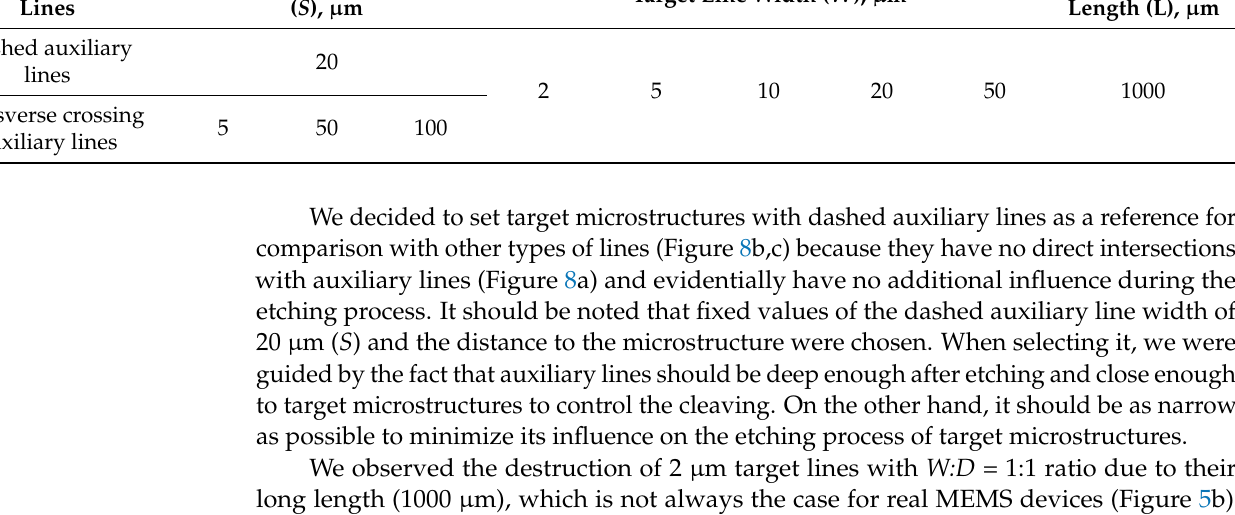
Figure 8. Test topology appearance: ( a ) Dashed auxiliary line (reference); ( b ) Transverse crossing auxiliary line in the center; ( c ) Transverse crossing auxiliary line on the edge.